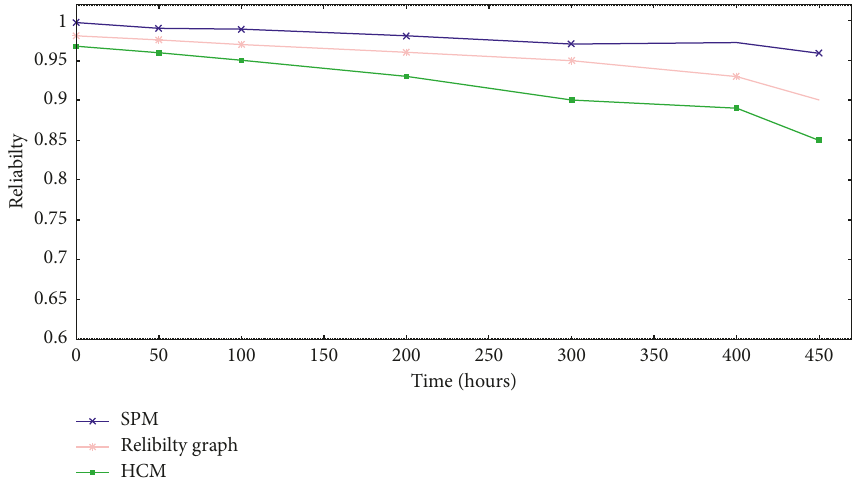
Figure 5: Comparison with other reliability